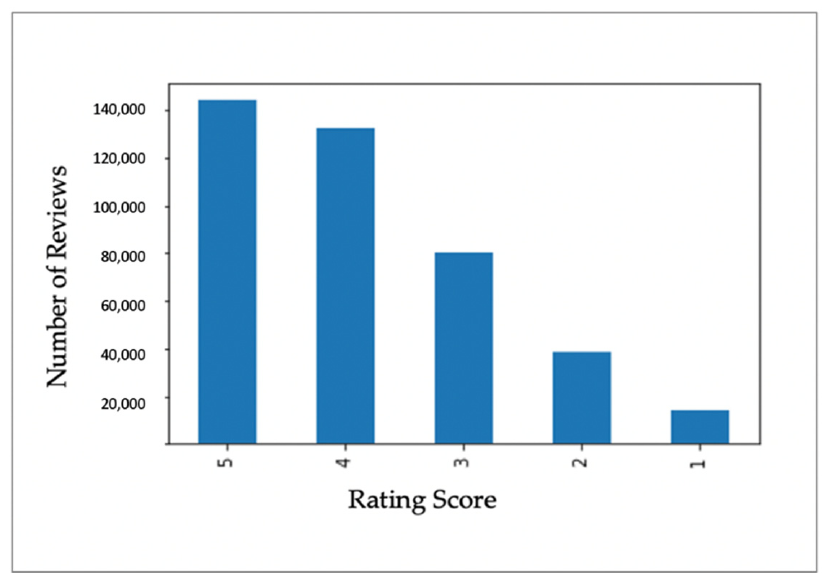
Figure 2. Reviews class frequency chart according to the users’ rating.